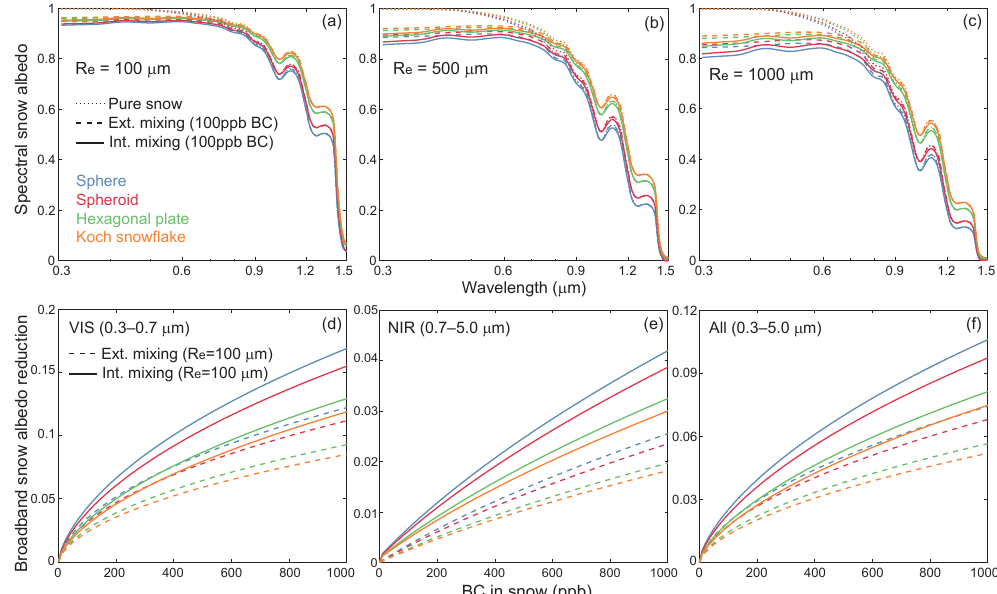
Figure 4. (a–c) Spectral (0.3–1.5µm) direct-beam albedo of semi-infinite snow layers with effective radii ( R e ) of (a) 100, (b) 500, and (c) 1000µm for pure snow (dotted lines), snow externally mixed with 100ppb BC (dashed lines), and snow internally mixed with 100ppb BC (solid lines) with shapes of sphere (blue), spheroid (red), hexagonal plate (green), and Koch snowflake (orange) based on the updated SNICAR model. The results for 1000ppb BC and diffuse snow albedo are shown in Fig. S2 in the Supplement. (d–f) Same as (a–c) , but for broadband albedo reduction as a function of BC concentration in snow with R e of 100µm at (d) visible (VIS, 0.3–0.7µm), (e) near-infrared (NIR, 0.7–5µm), and (f) all (0.3–5µm) wavelengths. The results for snow with R e of 500 and 1000µm and diffuse albedo reductions are shown in Figs. S3 and S4 in the Supplement,